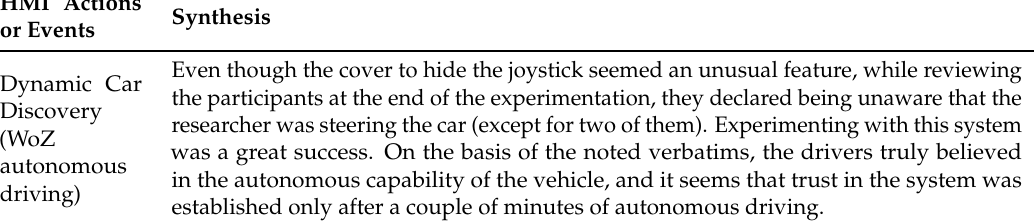
Table 1. Synthesis in terms of user experience per event and HMI actions taken in Discovery—Positive Phase. Further details and verbatims pronounced by the participants can be found in Appendix A.1.